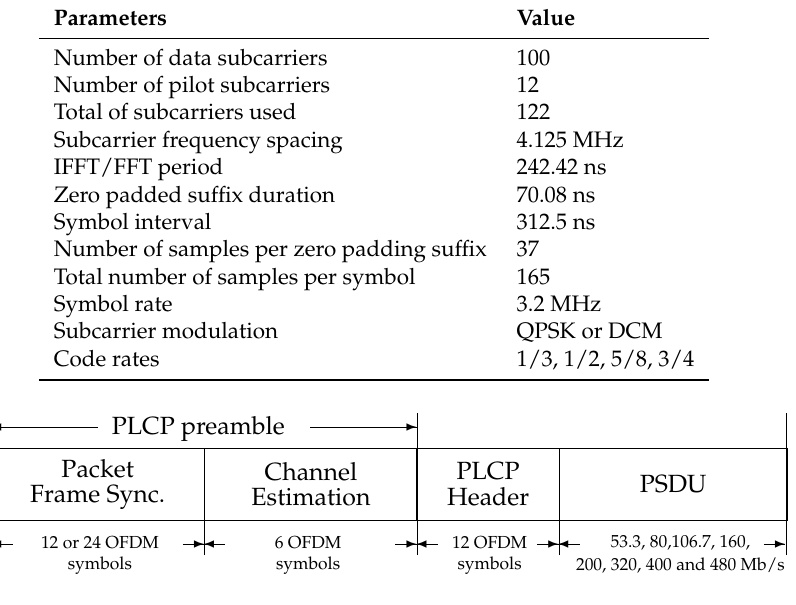
Figure 2. PHY frame